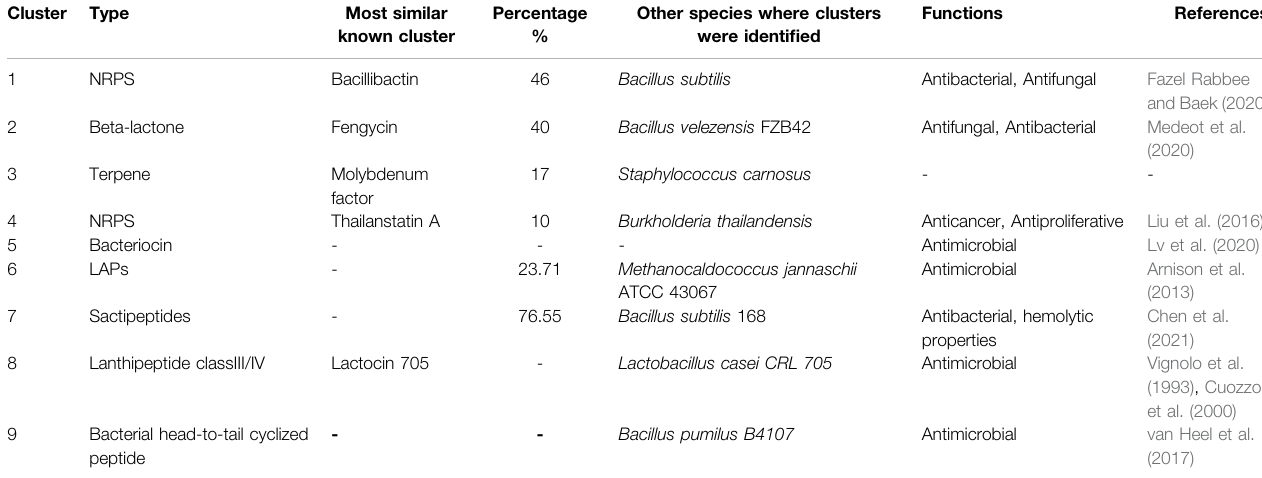
TABLE 2 | Identi fi ed secondary metabolite gene clusters in Bacillus paranthracis strain MHSD3 using anti-SMASH, BAGEL 4, and PRISM. Cluster